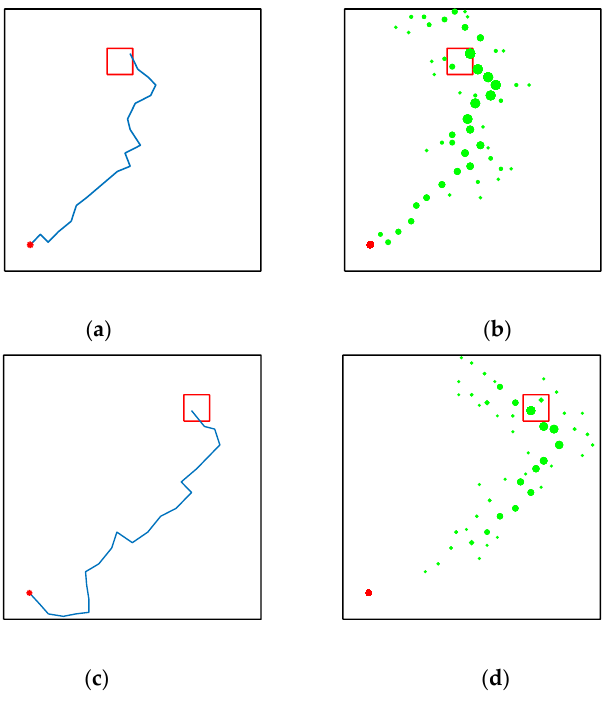
Figure 19. Performance of the brain-inspired model with olfactory system in the water maze experiment. ( a , b ) The calculated paths of the model when changing the position of the survival platform. ( c , d ) Signal propagation diagrams for navigation at different locations of the survival platform.